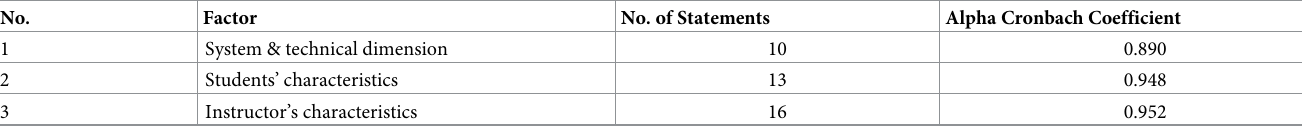
Table 2. The Alpha Cronbach Coefficient values for each factor. No.